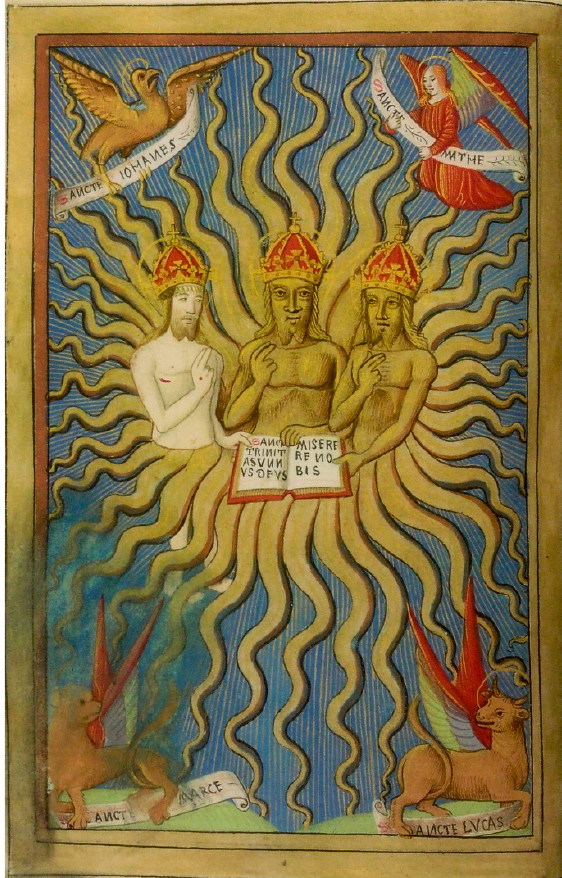
Figure 13. Holy Trinity, pair A of the Hours of the Earls of Ormond, ff . 6v and 33v, © British Library Board.